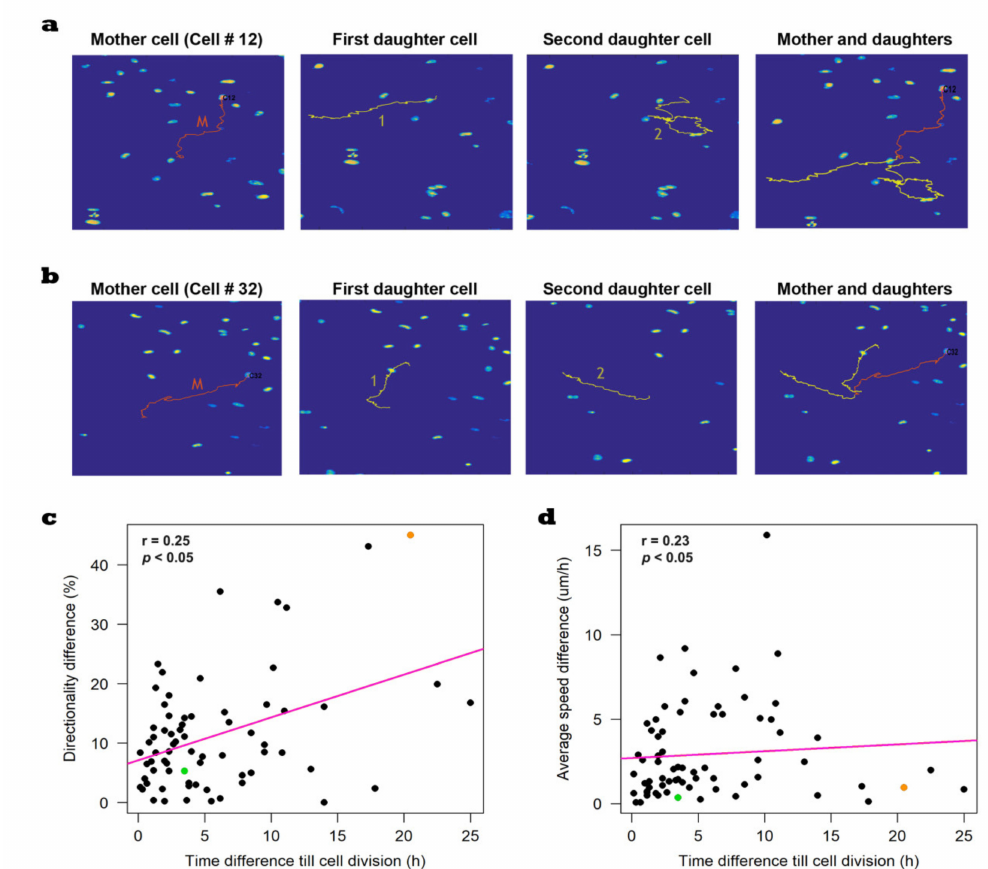
Figure 4. Representative examples of the heterogeneity between BT549 daughter cells. ( a ) An example of a cell (cell number 12 in red) with heterogeneous daughter cells (yellow). ( b ) An example of a cell (cell number 32 in red) with relatively homogeneous daughter cells (yellow). ( c , d ) Weak correlation between the time difference till cell division with both the directionality difference between daughter cells (Spearman’s rank correlation coefficient = 0.25) and the average speed difference (Spearman’s rank correlation coefficient = 0.23) between daughter cells. In the scatter plots, the orange dot represents the difference between daughter cells of cell number 12, whereas the green dot represents the difference between daughter cells of cell number